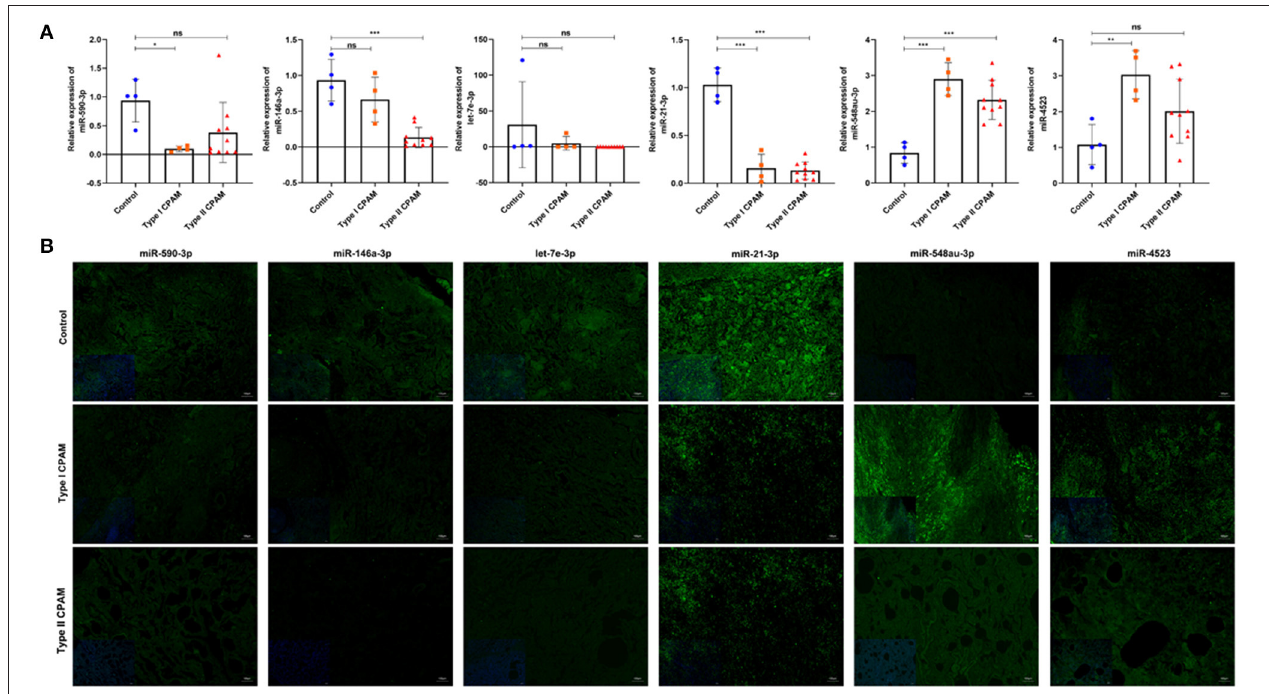
FIGURE 4 | Expression of miRNAs was detected using qRT-PCR and FISH in type I, type II CPAM, and control groups. (A) Expression of miR-140-5p, miR-21-3p, miR-590-3p, miR-146a-3p, and let-7e-3p in type I, type II CPAM and control groups, respectively. The data presented as mean ± SD. U6 acts as a control. * P < 0.05; ** P < 0.01; *** P < 0.001. (B) Expression and distribution of miR-140-5p, miR-21-3p, miR-590-3p, miR-146a-3p, and let-7e-3p in type I, type II CPAM and control groups, respectively. Bar = 50 µ